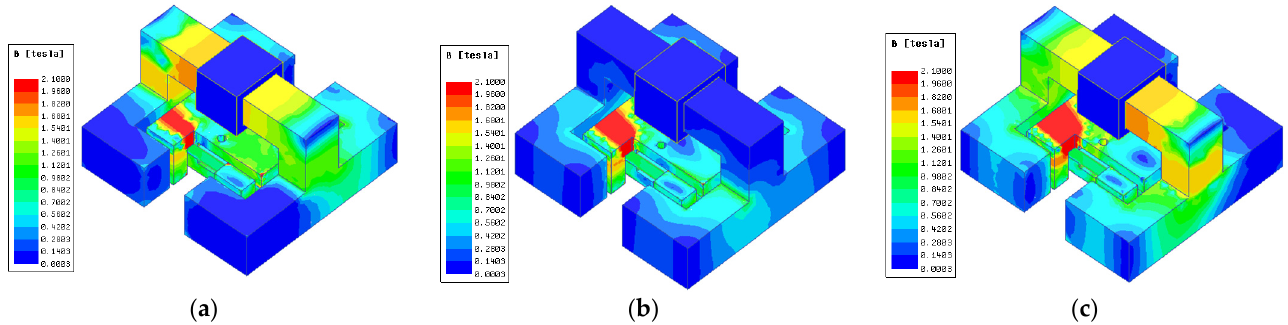
Figure 13. The magnetic field cloud diagram of NLFM. ( a ) x = 0 mm, i = − 2 A. ( b ) x = 0 mm, i = 0 A. ( c ) x = 0 mm, i = 2 A.